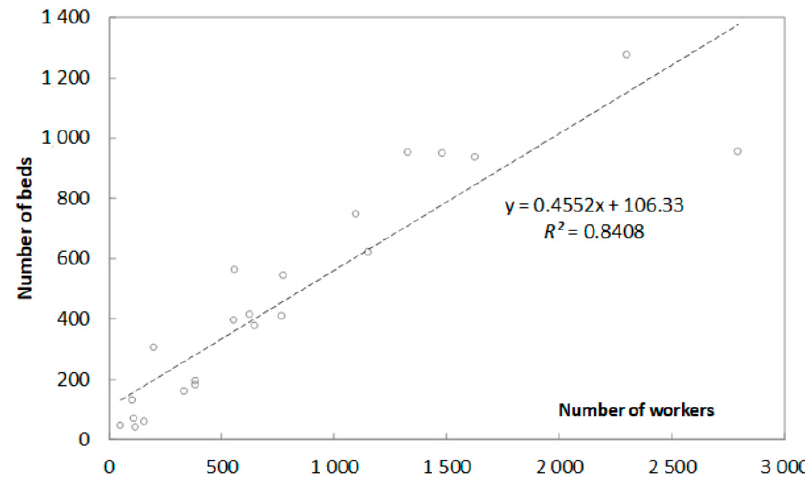
Figure 2. The relation between the number of beds and the number of workers for the hospitals under study.